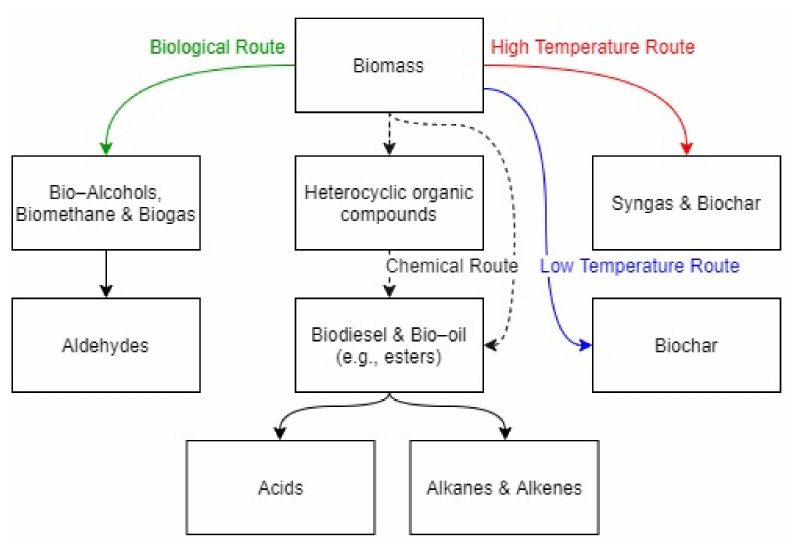
Figure 2. Simplified pathway representative of alternatives for biomass transformation toward biofuels, adapted from Cossu et al. [22]. Table 1. Physicochemical properties of some promising oxygenated fuels: LHV = lower heating value; λ = heat of vaporization; AIT = autoignition